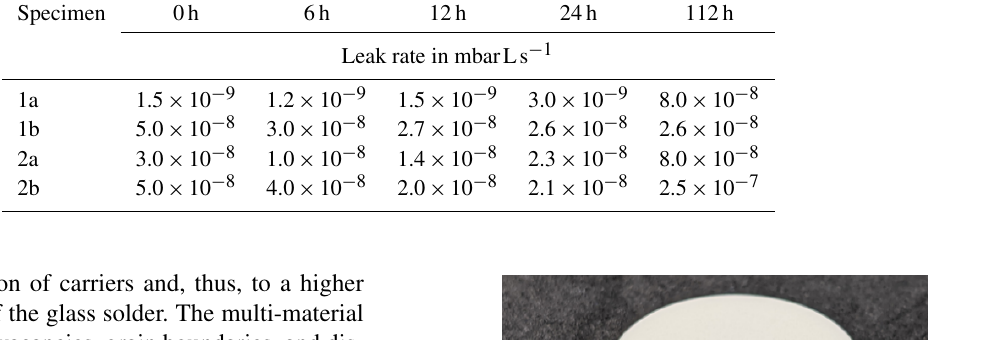
Table 6. Helium leak rates over the time of thermal ageing at 1000 ◦ C. Specimen